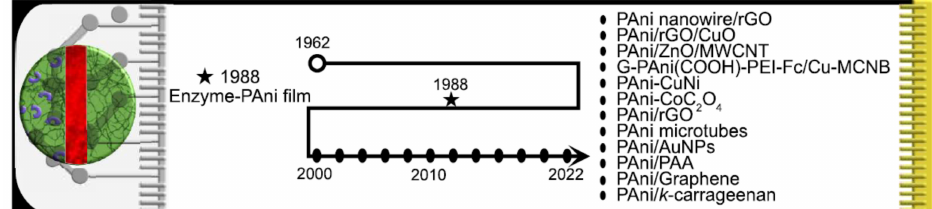
Figure 1. Graphical description of PAni-based glucose sensors (PBGS)